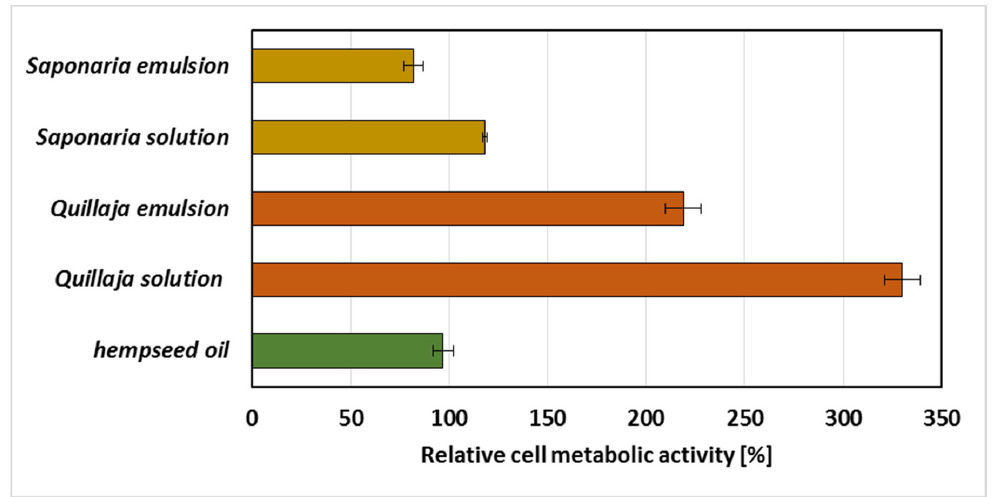
Figure 7. Relative metabolic activity of Pseudomonas fluorescens ATCC 17400 exposed to hempseed oil and water solutions and emulsions of plant extracts from Saponaria officinalis and Quillaja saponaria, with the metabolic activity in control sample set as 100% (SD presented as error bars).